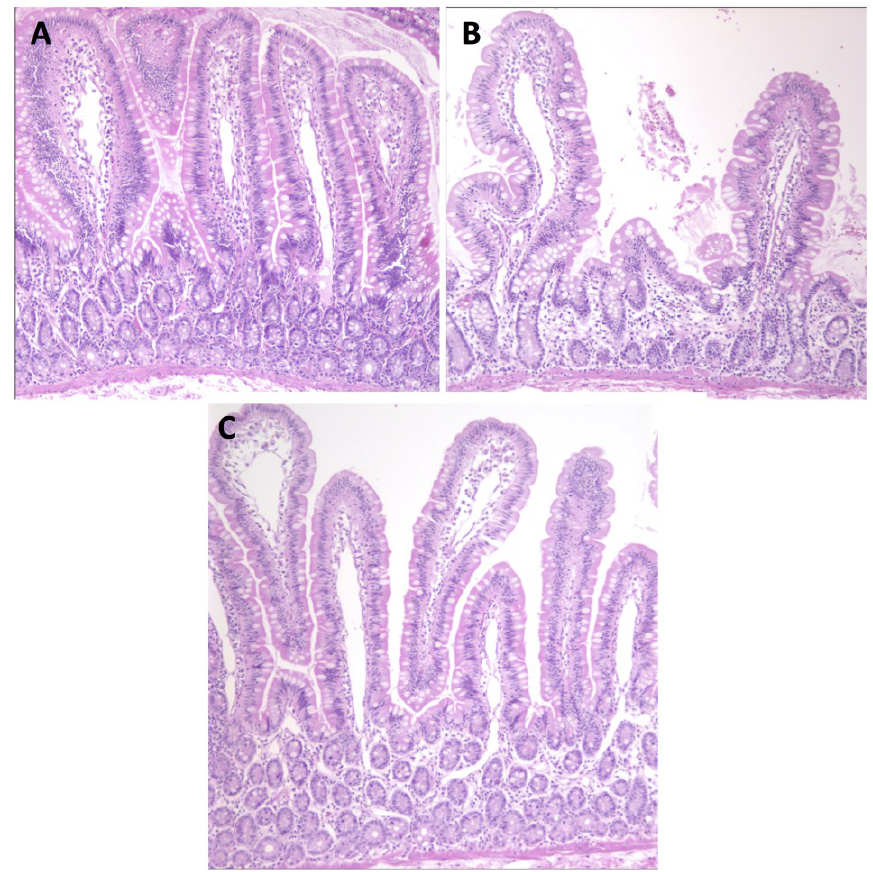
Figure 2. The effects of conventional and RG barley diets on small intestinal tissue architecture of control and GS macaques (H & E staining, jejunum, 100×). After being on conventional barley diet for 64 days, jejunum of control macaque (KD17) looks normal, unaffected, with only minimal lacteal dilatation ( A ) while GS macaque (KF97) jejunum is showing shortened villi e.g., villous atrophy ( B ). Multifocally, KF97’s lamina propria is moderately expanded by lymphoid aggregates. The lacteals are mildly dilated (lymphangiectasia). The submucosa is expanded by edema containing infiltrates of small number of neutrophils, eosinophils, lymphocytes and plasma cells (B). Follow-up treatment of KF97 with RG barley diet for 56 days resulted in an improvement: Jejunum became close to normal, with only moderate lymphangiectasia ( C